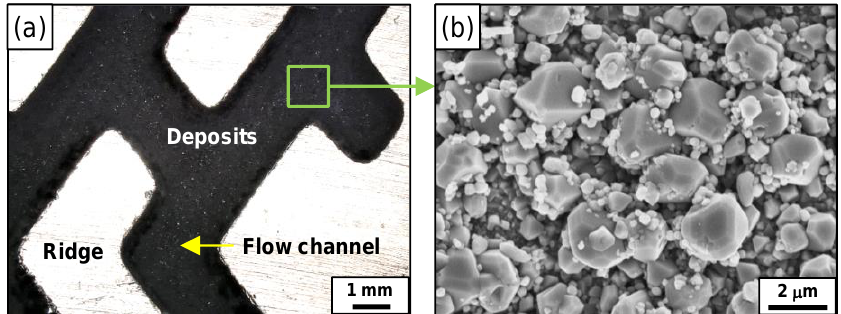
Figure 6. Images of the PCHE flow channels after the fouling test: ( a ) optical and ( b ) SEM.